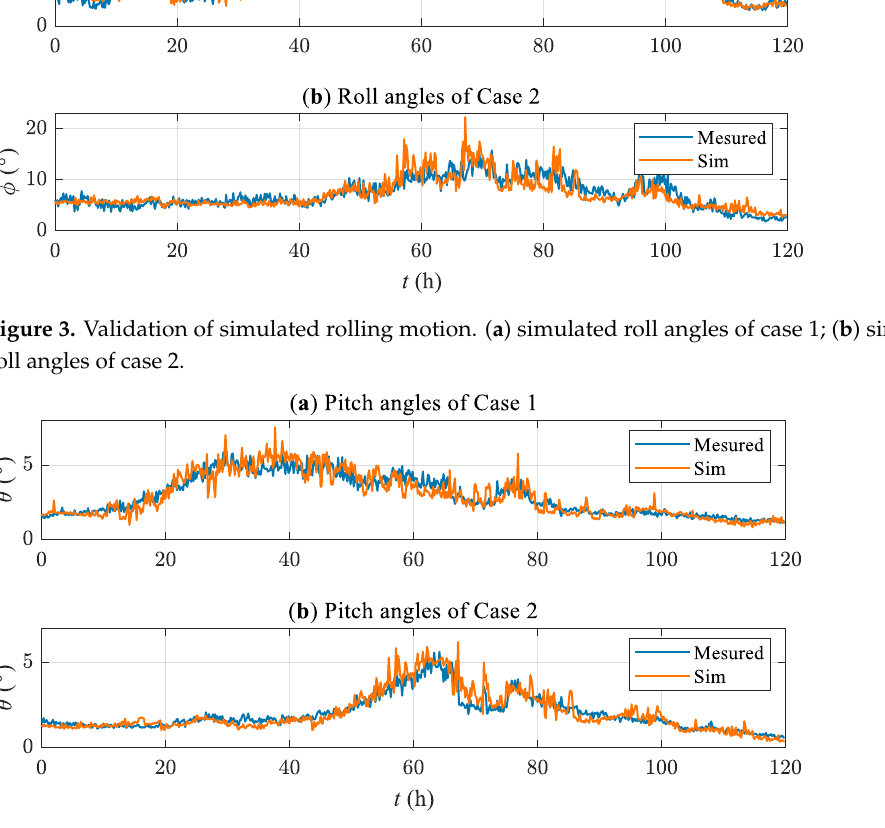
Figure 4. Validation of simulated pitching motion. ( a ) simulated pitch angles of case 1; ( b ) simulated pitch angles of case 2.